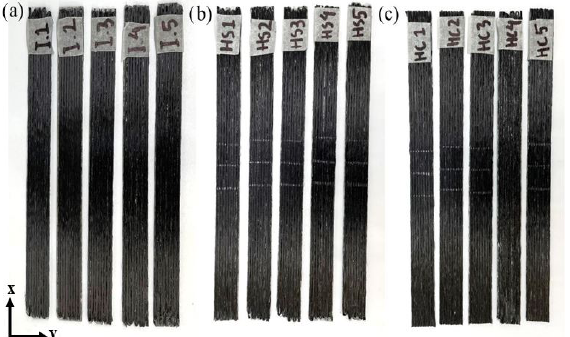
Figure 1. The 15 CFRP composite specimens printed with the FDM method for ( a ) intact/no treatment, ( b ) continuous temperature, and ( c ) cyclic